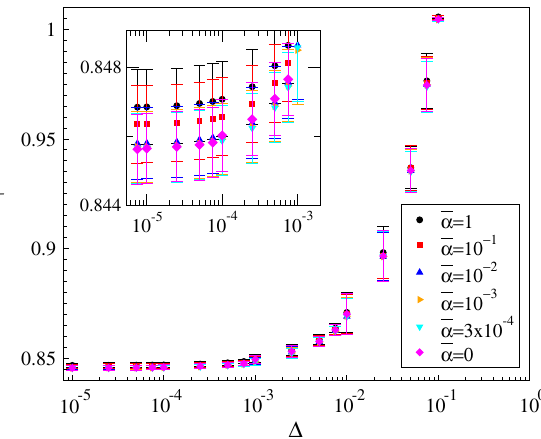
FIG. 10. Top: Density of states D ð ω Þ for different dimension- FIG. 11. Packing fraction ϕ as function of dimensionless less pressures Δ at fixed ¯ α ¼ 10 − 3 , with the prestress term pressure Δ measured for packings in which radii are not allowed to fluctuate, and whose distribution of radii is borrowed from included (dashed lines) and excluded (continuous lines). Inset: − 4 and at different values of Characteristic frequencies ω (cid:3) and ¯ ω (as marked in the main SWAP packings generated at Δ ¼ 10 ¯ α , as indicated by the legend. The inset shows an enlargement of panel) versus Δ . Dashed line correspond to the marginality ffiffiffiffi ffiffiffiffi p p Δ Δ condition ω (cid:3) ∼ and ¯ ω ∼ . Bottom: D ð ω Þ for different very small dimensionless pressures, demonstrating that the value ¯ α and fixed Δ ¼ 10 − 4 . Note that for these curves ω (cid:3) 2 = ¯ ω 2 ≈ 5% , depends very weakly on the borrowed distribution of radii of ϕ c indicating that the system is very close to marginal stability. of the SWAP packings, as determined by the parameter ¯ α